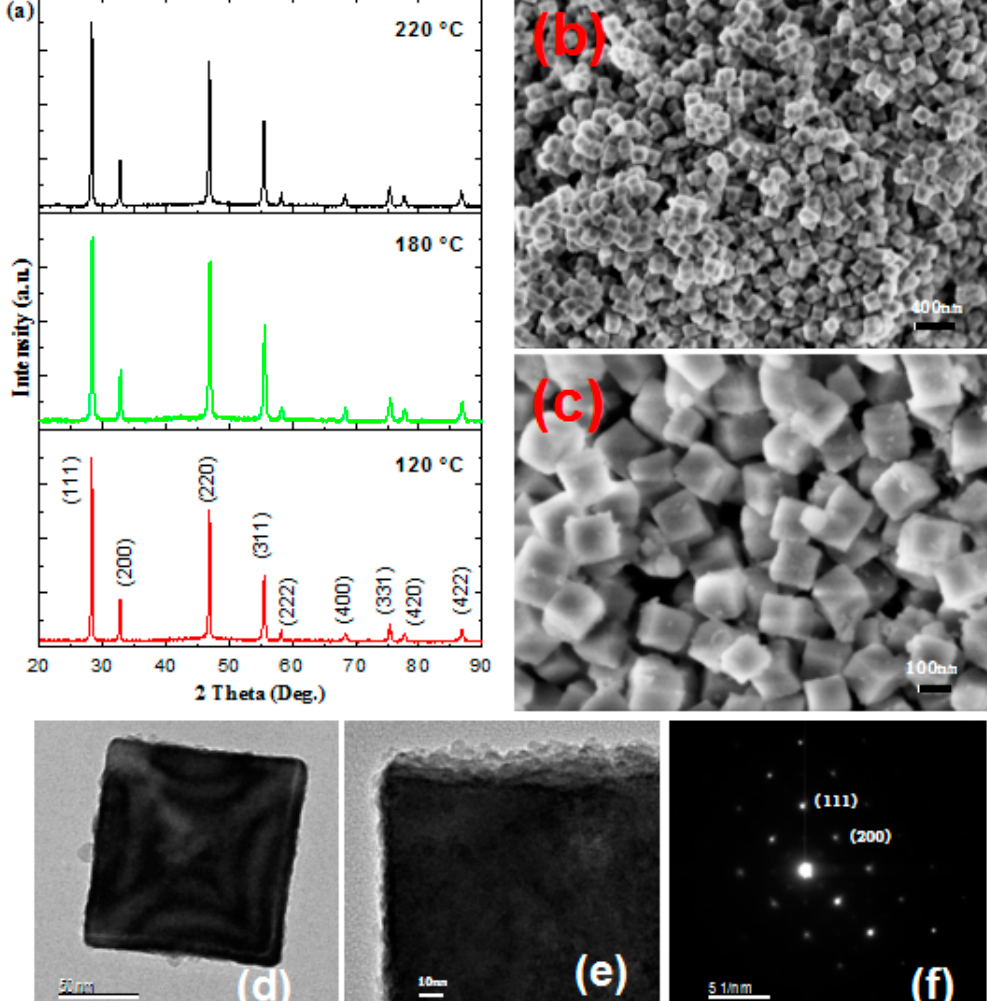
Figure 1. ( a ) X-ray diffraction (XRD) patterns of sodium yttrium fluoride (NYF):Yb 3+ Er 3+ (20/2 mol%) sample at various solvothermal temperatures using diethylene glycol (DEG) as the reaction medium (all of the diffraction peaks are attributed to cubic-phase NaYF 4 ), field-emission scanning electron microscope (FE-SEM) images (( b ) low-magnification; ( c ) high-magnification), ( d , e ) TEM images, and ( f ) selected area electron diffraction (SAED) pattern of as-obtained NYF:Yb 3+ ,Er 3+ (20/2 mol%) submicrocrystals at 120 ◦ C. (Note the nanoparticles aggregated to form submicrocubes).